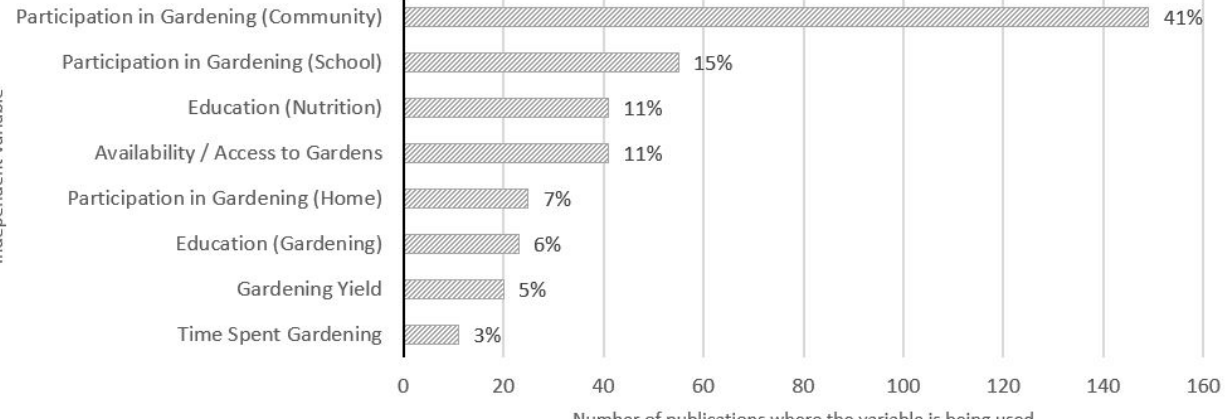
Figure 5. Studies by types of independent variable related to exposure to urban gardening spaces and/or activities. Note: Several studies in our sample ( n = 272) used more than one measure of exposure to or involvement in urban gardening, hence the total number of studies reported in this chart is higher than the total number of studies in our sample.